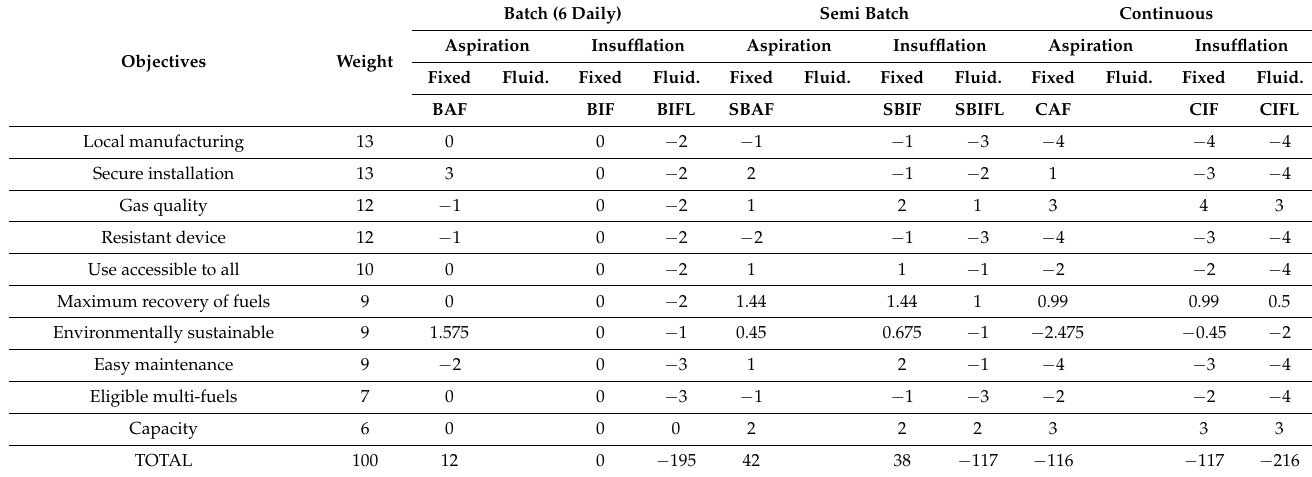
Table 6. Comparative scores given to the different reactors for the different objective. Scores are relative to the BIF case.